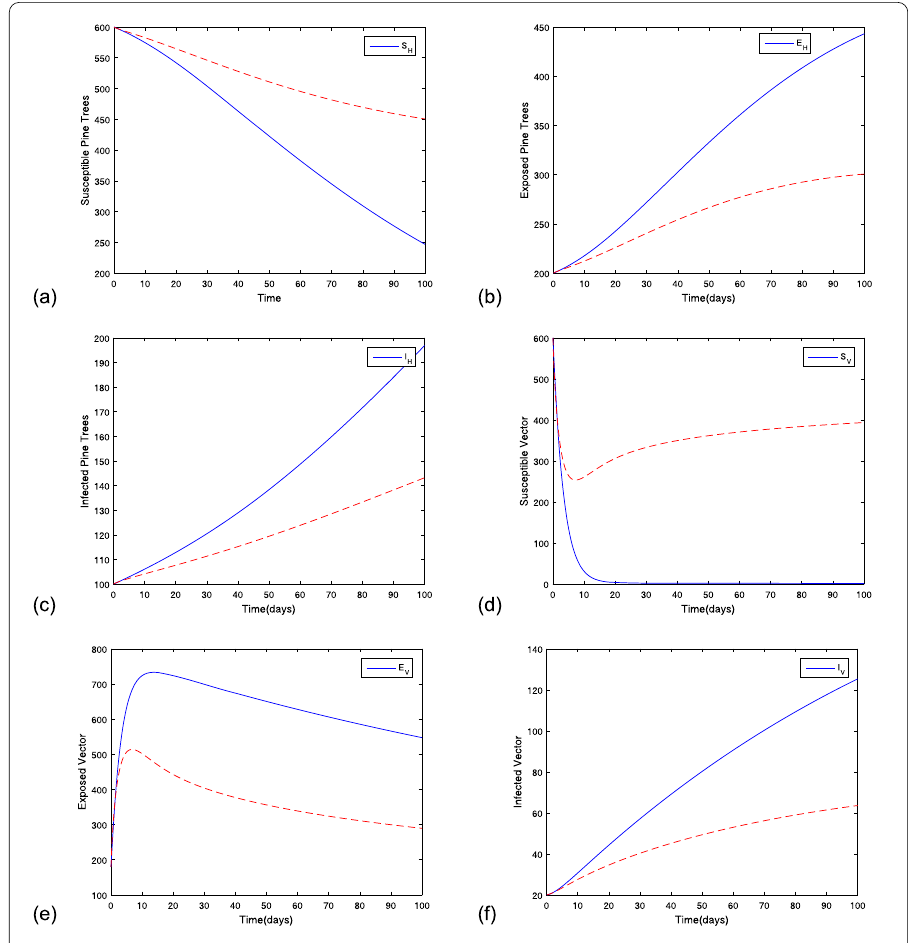
Figure 2 Simulations of pine tree population ( a )–( c ) and vector population ( d )–( f ) of the FPWD model (9) for τ = 0.8. ( a ): Susceptible pine tree; ( b ): Exposed pine tree; ( c ): Infected pine tree; ( d ): Susceptible vector; ( e ): Exposed vector; ( f ): Infected